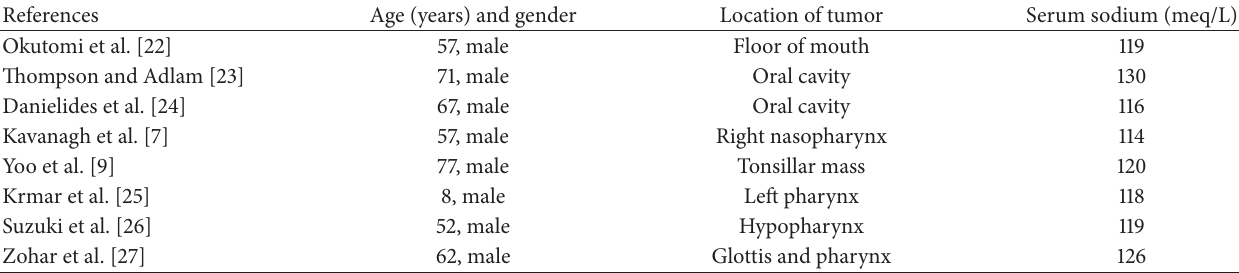
Table 1: Table with brief review of cases of SIADH secondary to pharyngeal squamous cell